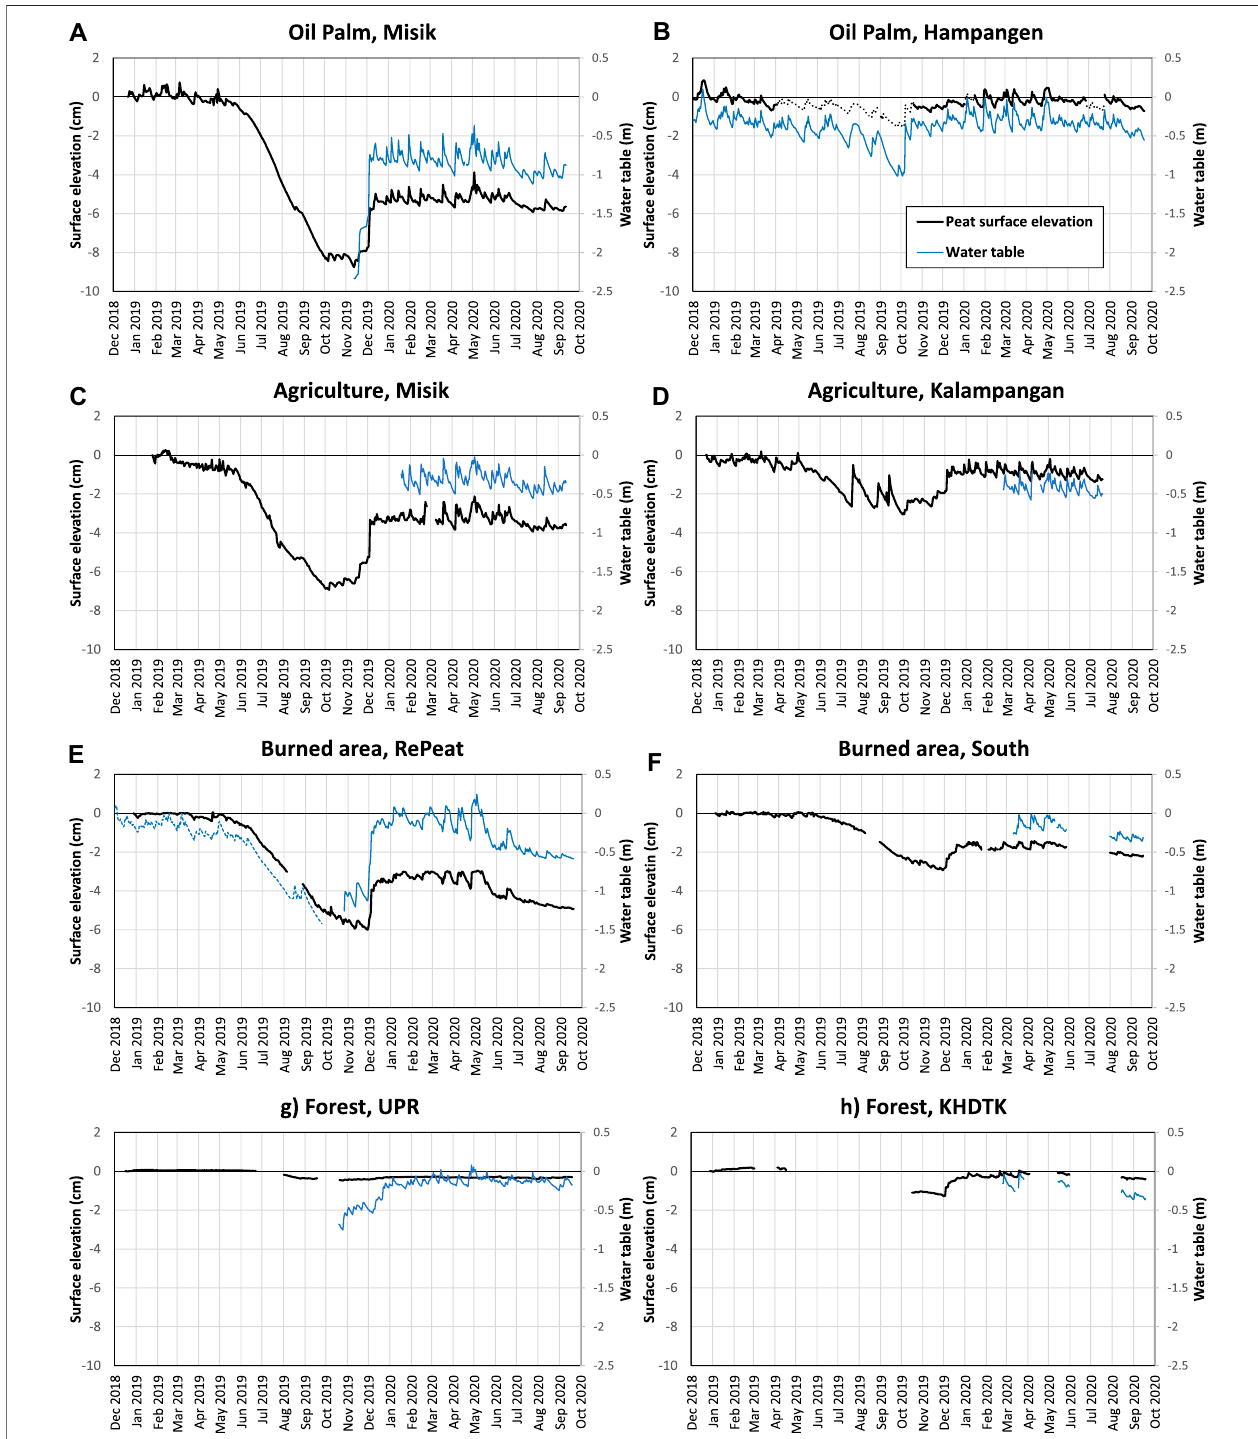
FIGURE 9 | Time series of peat elevation (black, left y -axis) and water table depth (blue, right y -axis) over the full measurement period. All data are plotted on the same y -axisscalestofacilitatecomparison.TheblackdashedlineatHampangenOilPalmindicatesdatathatweregap- fi lledusingWTDdataandthebluedashedlineat RePeat shows WTD data obtained from a pressure transducer operated nearby (see text for details). (A – H) are there as site identi fi ers to enable speci fi c panels to be referenced from the